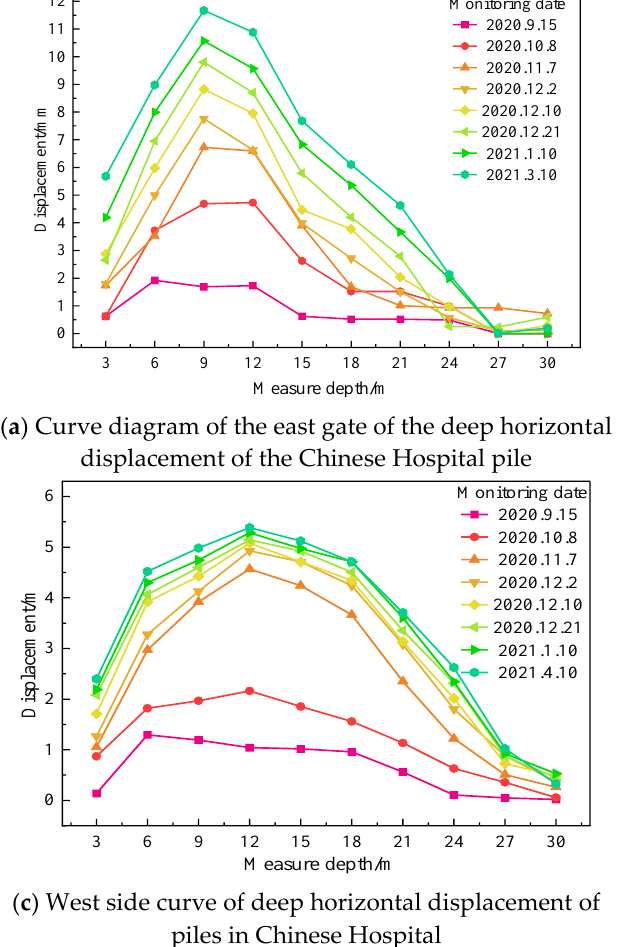
( c ) West side curve of deep horizontal displacement of ( d ) Curve diagram of the deep horizontal displacement of the soil on the south side of the Chinese Hospital 1#